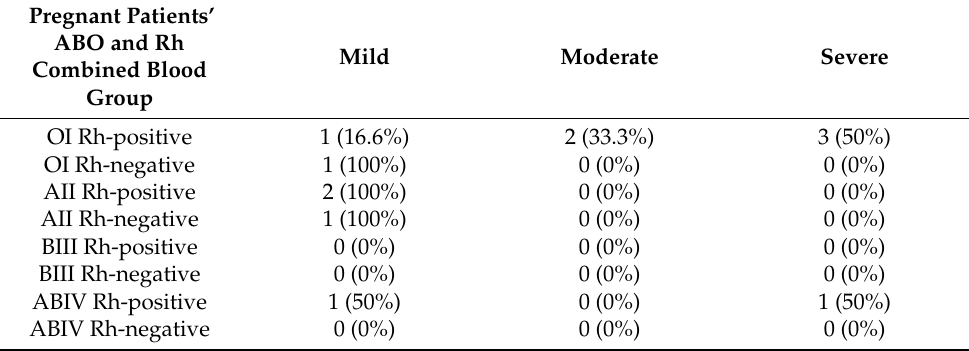
Table A3. Mild, moderate, and severe forms of COVID-19 in second and third trimester pregnant patients, according to ABO and Rh combined blood